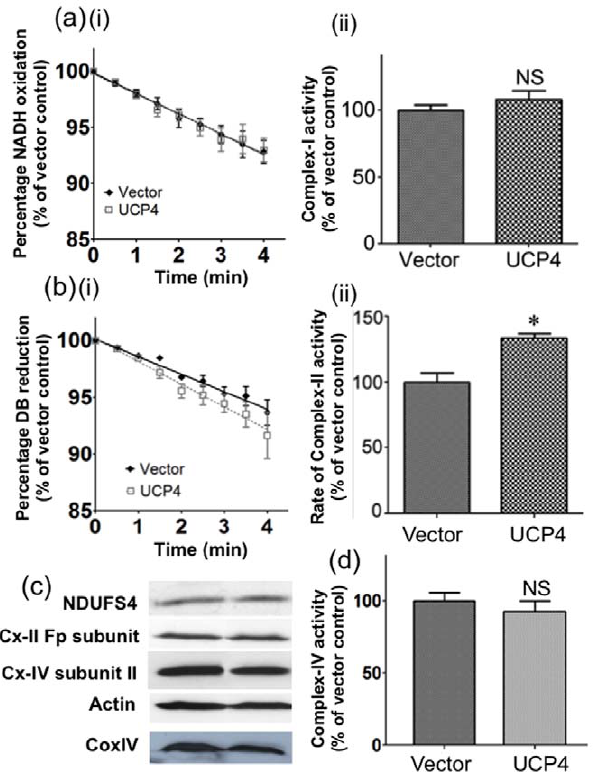
Figure 5. Mitochondrial Complex I, II and IV activity and expression levels in vector control and UCP4-overexpressing cells. Enzymatic activities of Complex I and II were measured in total cell lysates using spectrophotometric enzyme assay as described in Materials and Methods . (a)(i–ii) Complex I activity and (c) Complex I subunit, NADH dehydrogenase (ubiquinone) Fe-S protein 4